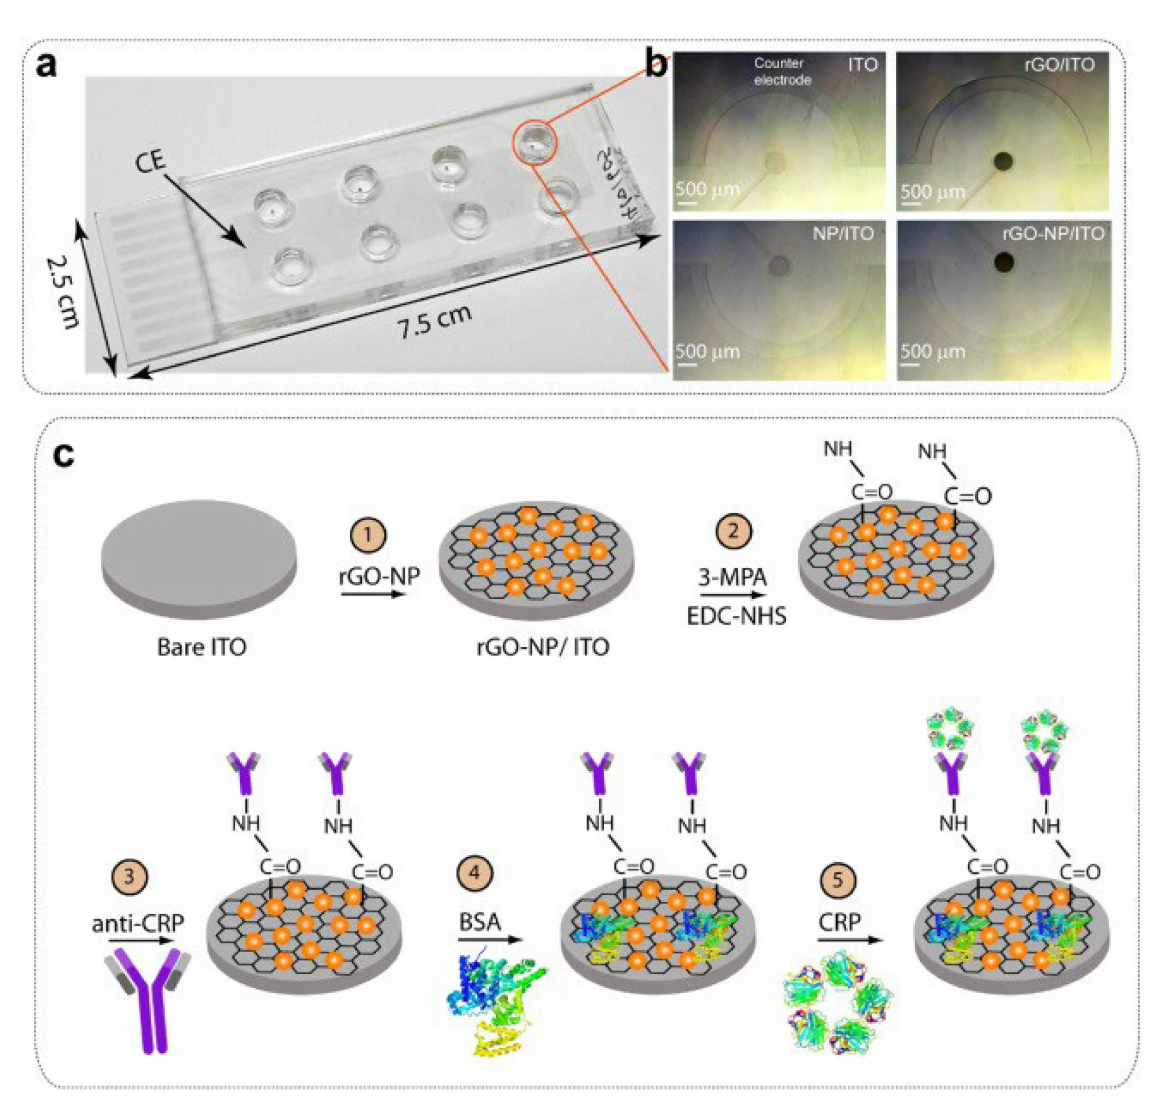
Figure 18. ( a ) Fabrication of the of the eight-channel microdisk array biosensor. It consists of rGO-AuNP/ITO-based circular working electrodes and only one counter electrode. ( b ) Optical images of the bare and modified electrodes along with a large ITO counter electrode. ( c ) Nano- material modifications of the ITO (rGO-NP functionalization) electrode and the preparation of the biosensing surface (EDC-NHS-based CRP antibodies binding on MPA-coated rGO-NP. Reprinted with permission from Ref. [122]. Copyright 2016,